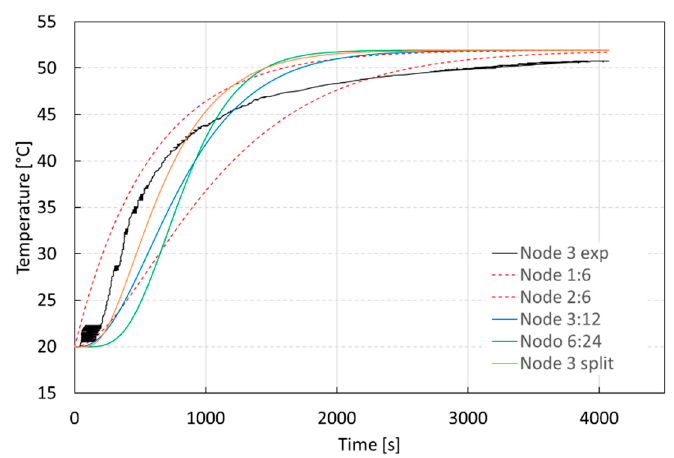
Figure 11. Experimental temperature evolution during the charge phase at node #3 vs. simulation results.